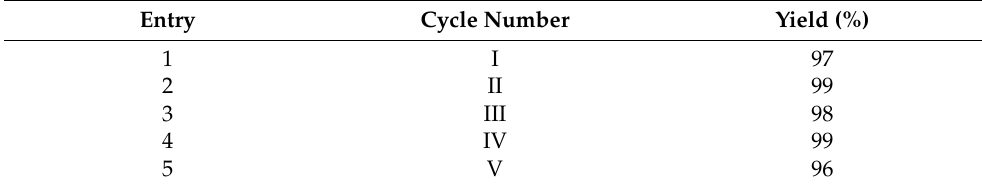
Table 6. Results from Recyclability tests a . Entry Cycle Number Yield (%) 1 I 97 2 II 99 3 III 98 4 IV 99 5 V